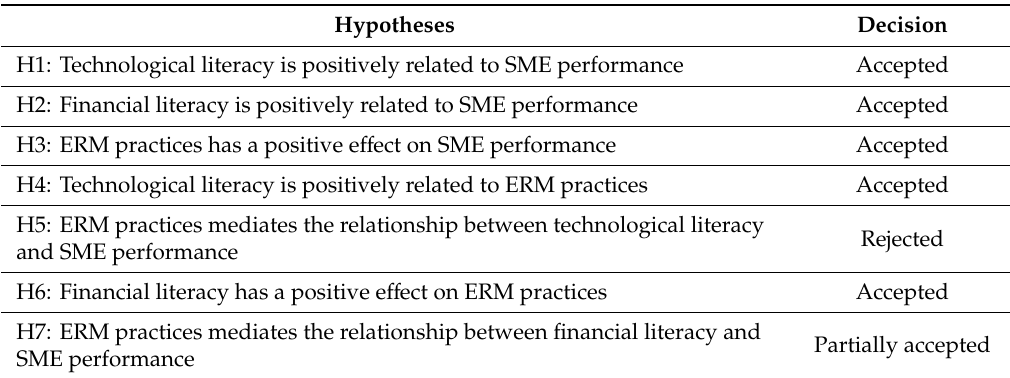
Table 8. Summary of hypothesis